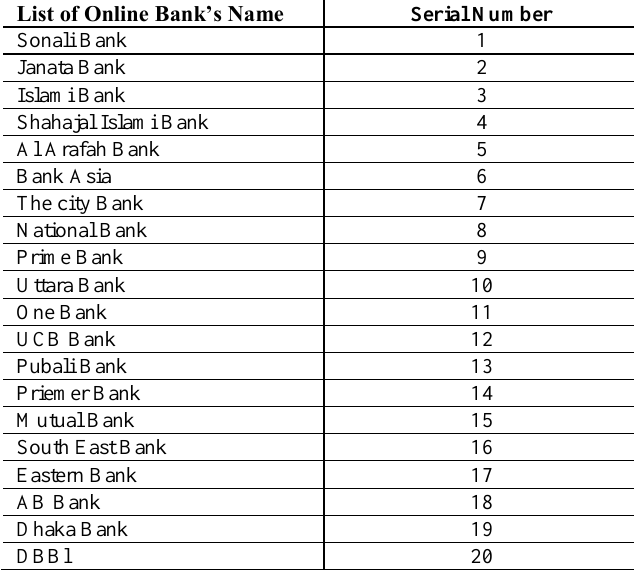
Table 1: List of online banks considered in this study List of Online Bank’s